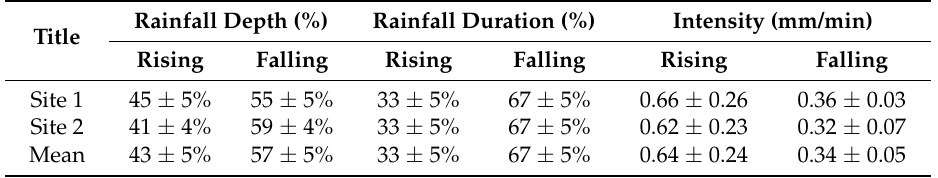
Table 3. Statistics of the rising and falling limbs for storm events at Sites 1 and 2 from 2008 to